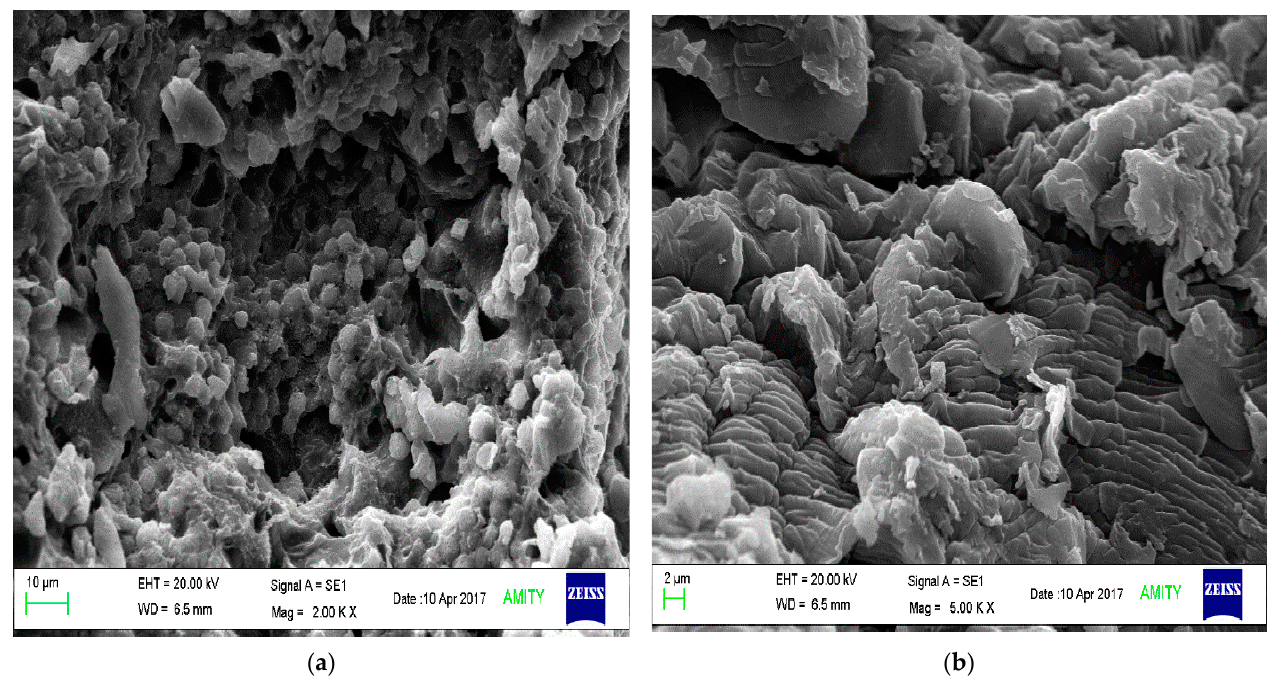
Figure 5. Scanning electron microscopy of ( a ) native TSP and ( b ) grafted copolymer (F1) .